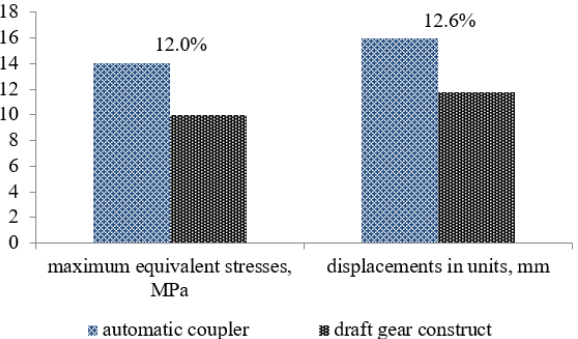
Figure 10. The comparative study of the simulated strength.